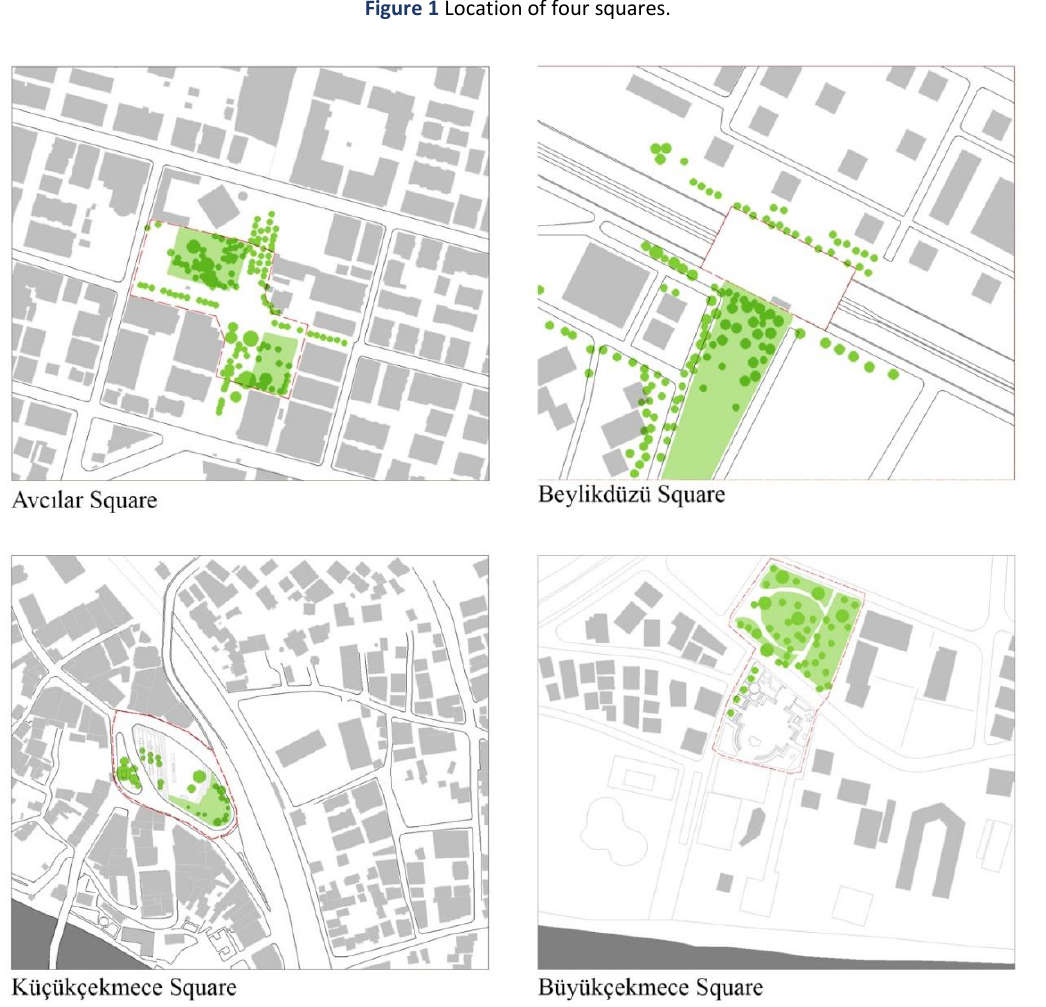
Figure 2 The squares within their immediate urban